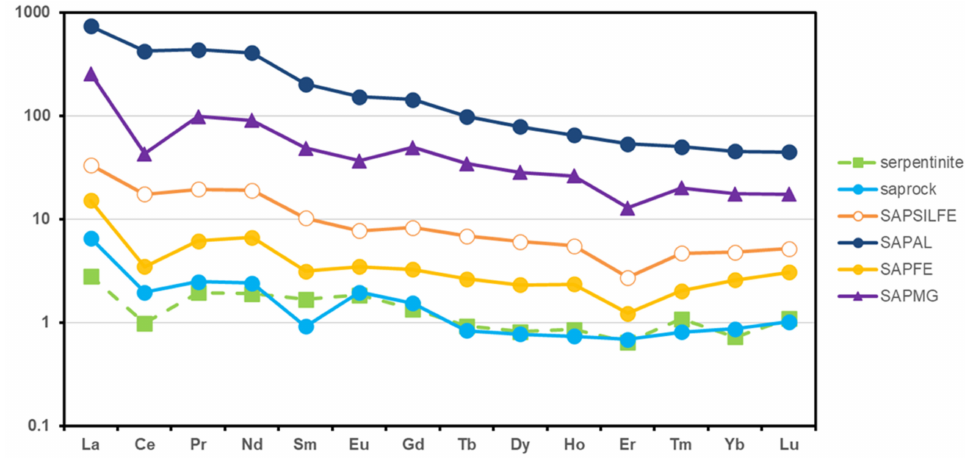
Figure 6. Chondrite normalised REE plots averaged within the profile units. REE concentrations are normalised to the CM values of